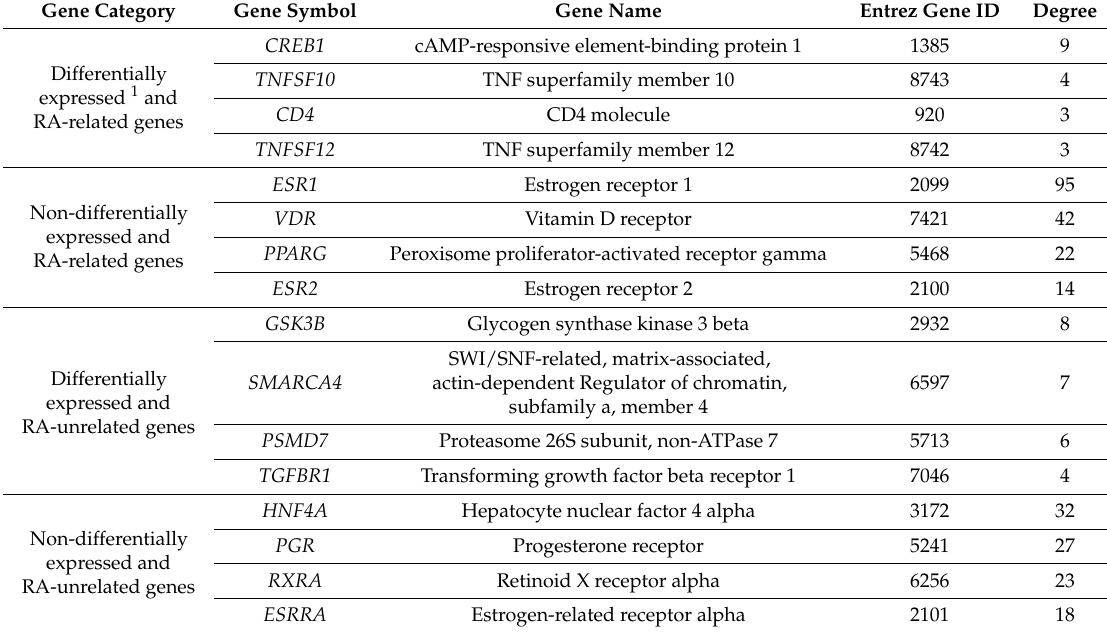
Table 2. The top 4 hub genes in each category in the rheumatoid arthritis (RA)-specific NIM subnetwork based on